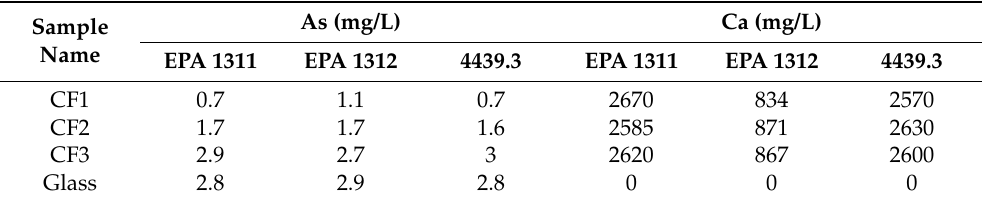
Figure 4. Arsenic and calcium release from cement-encapsulated and glass materials ( a , b ) method 1311; ( c , d ) method 1312; ( e , f ) AUS. 4439.3. Table 3. Arsenic and calcium concentration in